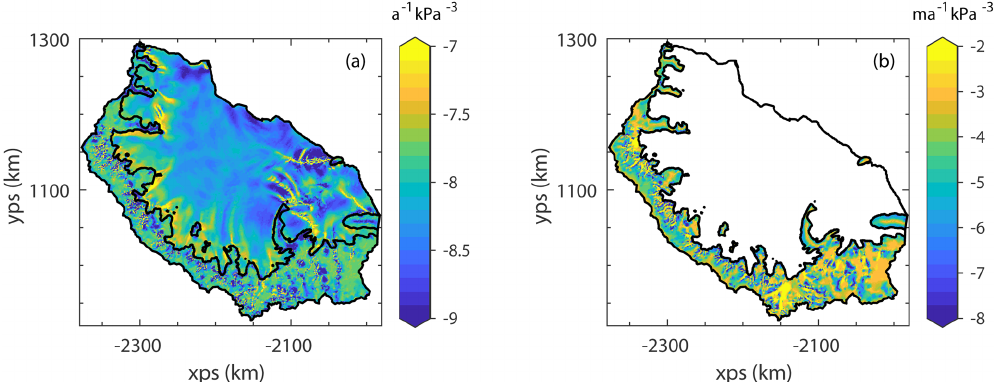
Figure A2. Maps of (a) the rate factor, A , in Glen’s flow law (Eq. 3) and (b) the basal slipperiness, C , in the Weertman sliding law (Eq. 5) after optimisation as set out in Sect. 2.3. The colour bars have been saturated to allow the spatial detail in both parameters to be clearly seen.